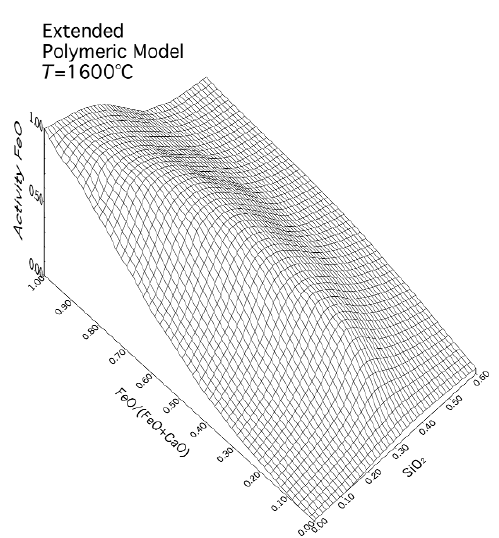
Fig. 2. FeO activity surface at 1600°C for liquid FeO-SiO 2 -CaO ternary system. Graphic representa- tion obtained by inverse-distance contouring of 9900 activity values generated by extended polymeric model, adopting, as limiting K p , 0.21 for FeO-SiO 2 join and 0.002 for CaO-SiO 2 join, respectively. As- sumed cationic interaction W Ca-Fe =− 33 kJ/mol. Strain energy contributions included (from Ottonel- lo, 2001, with